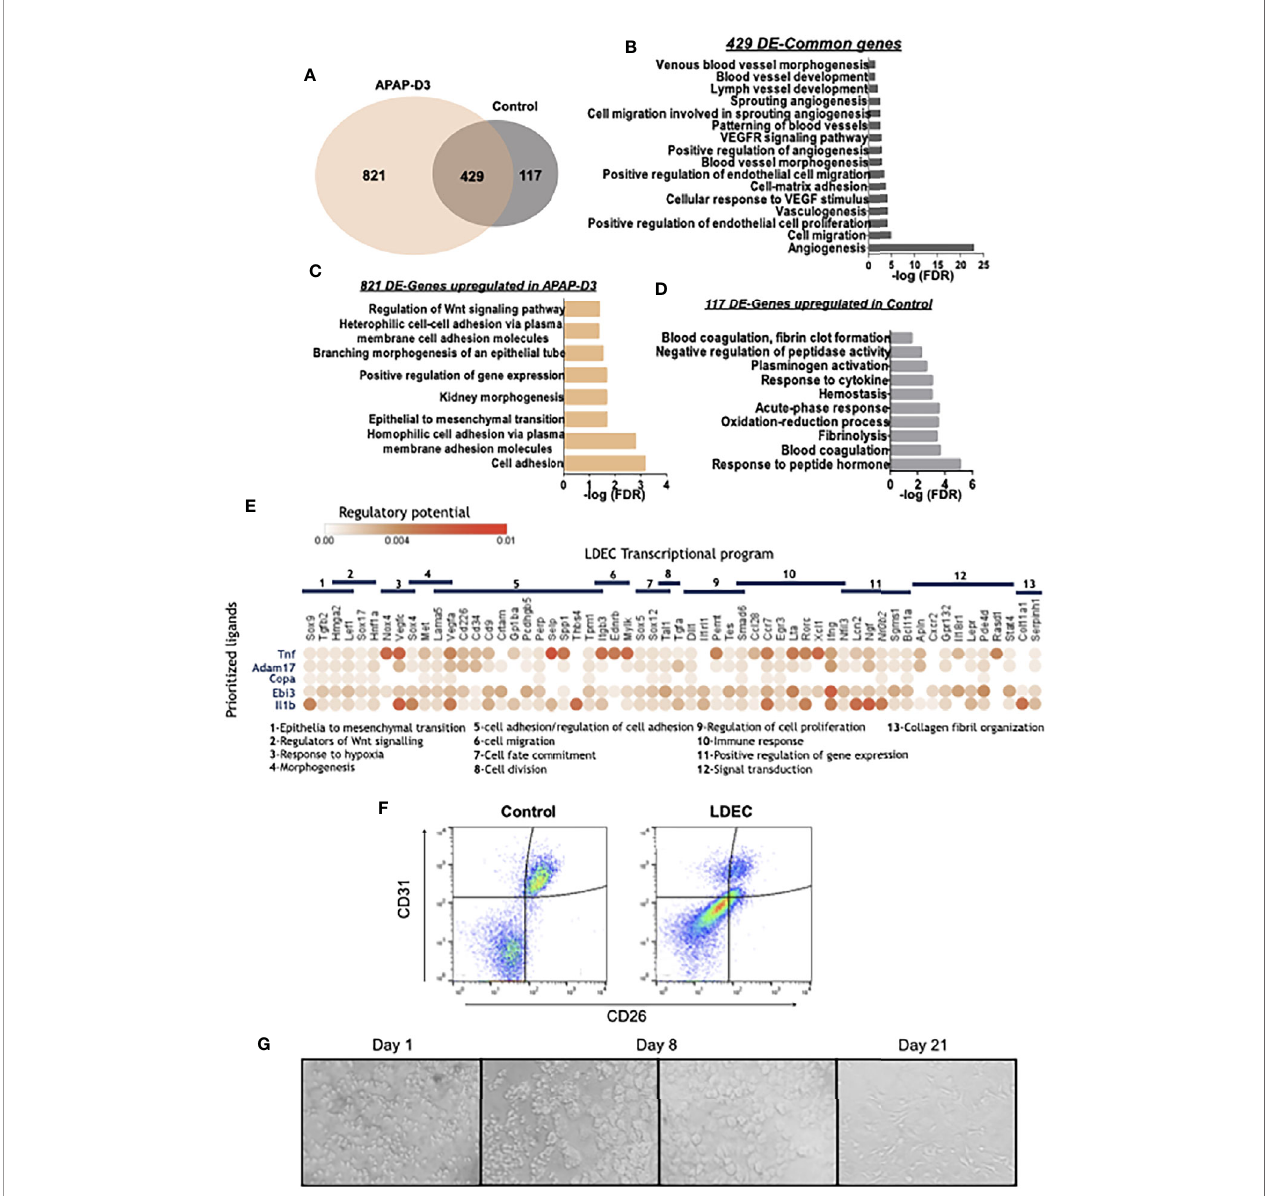
FIGURE 6 | LDECs identi fi ed among the CD45neg SSChi population by transcriptomic and phenotypic analysis and their interaction with transition macrophages. Venn diagram representing differentially expressed genes (DE-genes) upregulated in CD45neg SSChi population from APAP-D3 and untreated control mice. Kupffer cells (KC APAP-D3) transcriptomic data was used as a reference for DE-genes comparison (A) . Gene Ontology (GO) enrichment analysis in the ‘ Biological Process ’ category for common DE upregulated genes in APAP-D3 and control compared to KCs (B) for DE upregulated genes exclusively in APAP-D3 (C) and genes upregulated exclusively control mice (D) . GO terms over-represented for FDR (Bejamini)<0.05. Dot plot of ligand-receptor interactions between transition macrophages (y axis) and LDECs populations (x axis). Circle color denotes average strength of the regulatory potential between sender and receiver cells. LDECs associated gene ontology terms are identi fi ed (E) . Flow cytometry plots showing double staining for CD31 and CD26 in control and APAP-D3 (LDECs) CD45neg SSChi cells (F) . Sort-puri fi ed LDECs cultured in M-CSF supplemented medium at 1, 8 and 21 days (G)